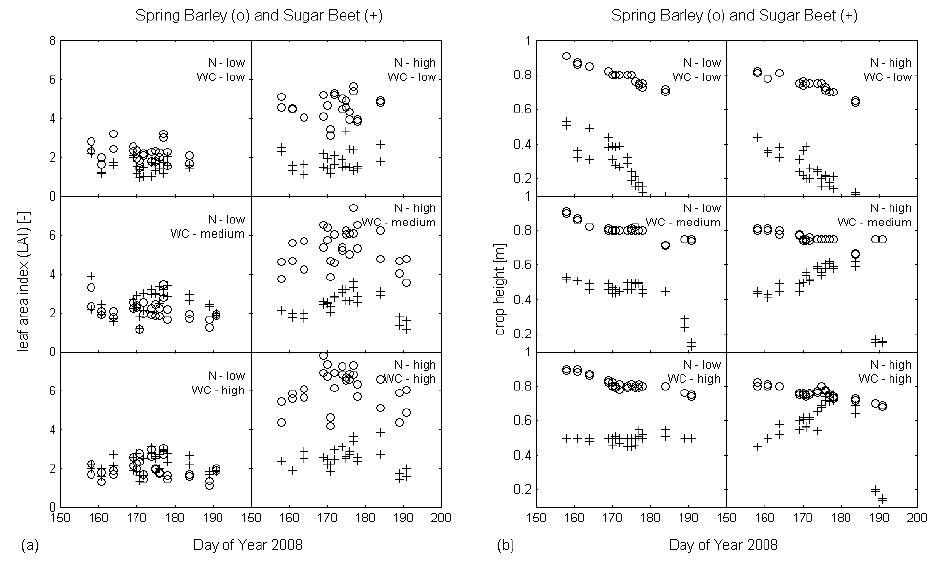
Figure 3. Temporal development of leaf area index (a) and of vegetation height (b) for Spring Barley (o) and Sugar Beet (+), plotted with regards to applied WC and N treatments (indicated in an upper right corner of all plots), BL 2008